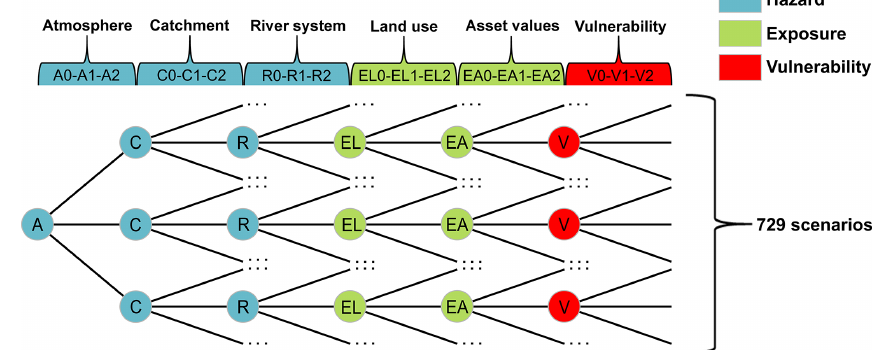
Figure 4. Conceptual scheme of combinations for six components (atmosphere, catchment, river system, land use, asset values, and vulner- ability). For each component, there is one baseline (denoted by 1) and two symmetric change scenarios (denoted by 0 and